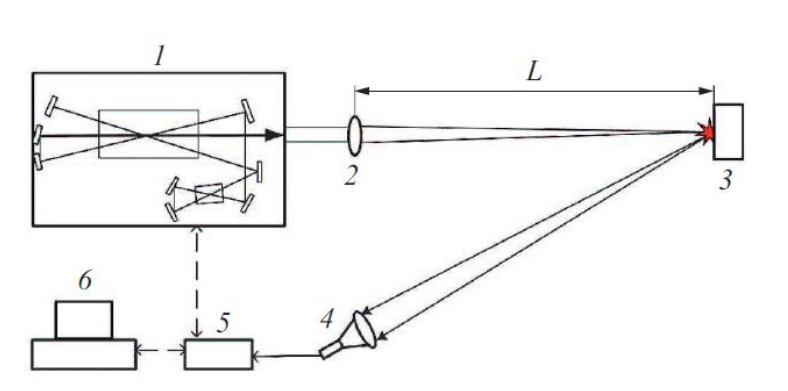
Fig. 1. Laser system for measurements by LSES: (1) Nd:YAG laser with self-phase conjugation, (2) focusing system, (3) sample under study, (4) radiation reception system, (5) spectrometer, and (6)